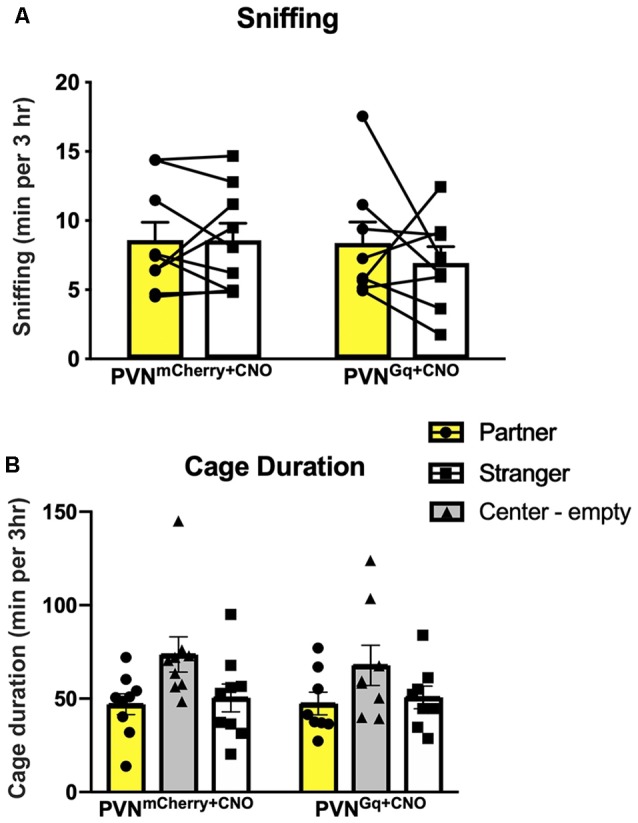
Social behaviors are unchanged by CNO treatment. (A) Sniffing duration of either the partner or stranger were similar within and across the tested groups. (B) Mice spent similar times in the chambers of the partner or the stranger conspecific in both groups as well as extensive time in the empty center chamber.